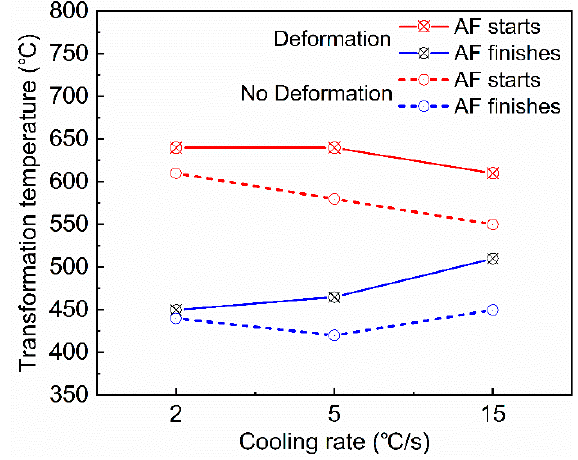
Figure 11. Effect of Mn on the kinetics of transformation calculated by Thermo-Calc. ( a ) Relationship between Ae 3 -temperature and Mn content; ( b ) ferrite formation driving force at different temperatures.